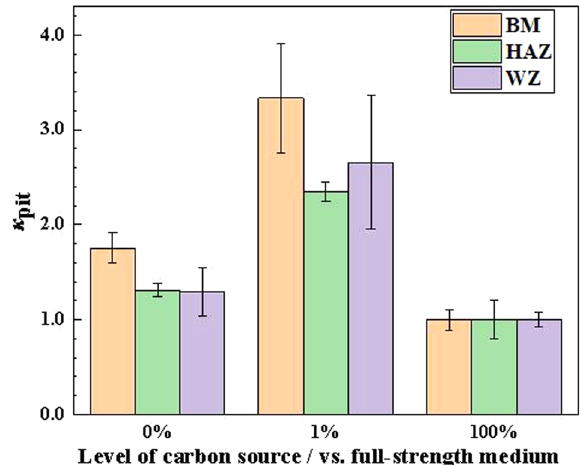
Fig. 9 κ pit for welded joints. The fi gure shows κ pit of organic carbon source starvation on SRB corrosion of BM, HAZ, and WZ for the welded joints (error bars stand for the standard deviations from three independent sample).